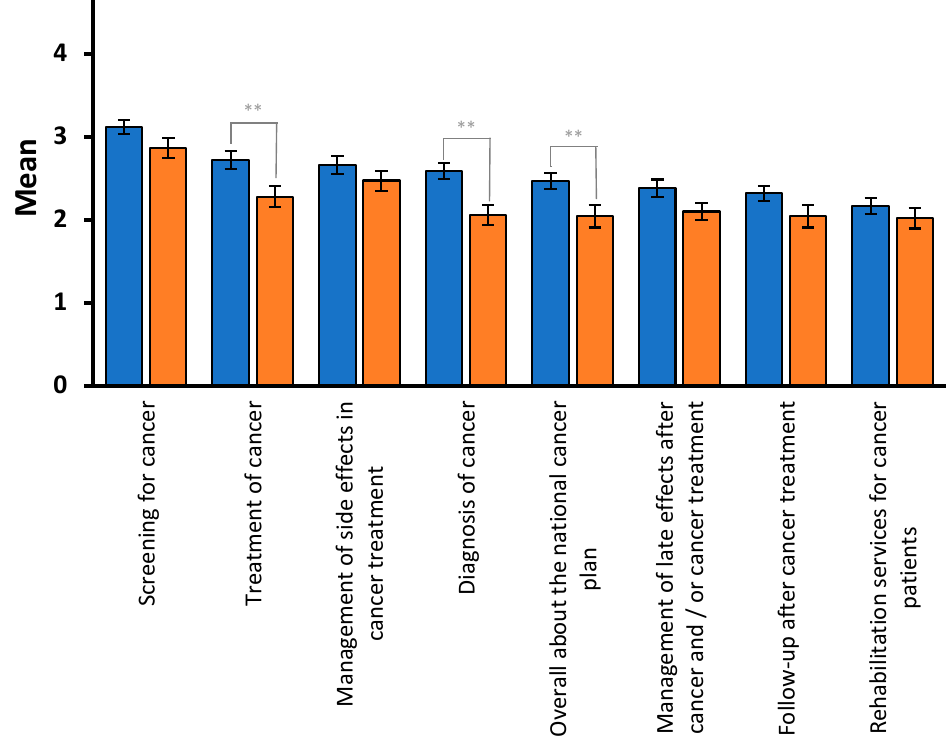
Figure A2. Self-perceived level of knowledge related to the topics about the organization of cancer care for pharmacists (n = 79) and pharmaconomists (n = 51), respectively. Ratings for knowledge are defined as: 1 No knowledge, 2 Very little knowledge, 3 Some knowledge, 4 A lot of knowledge, 5 In-depth knowledge. Pharmacists. Pharmaconomists. Error bars are SEM. ** p < 0.01.